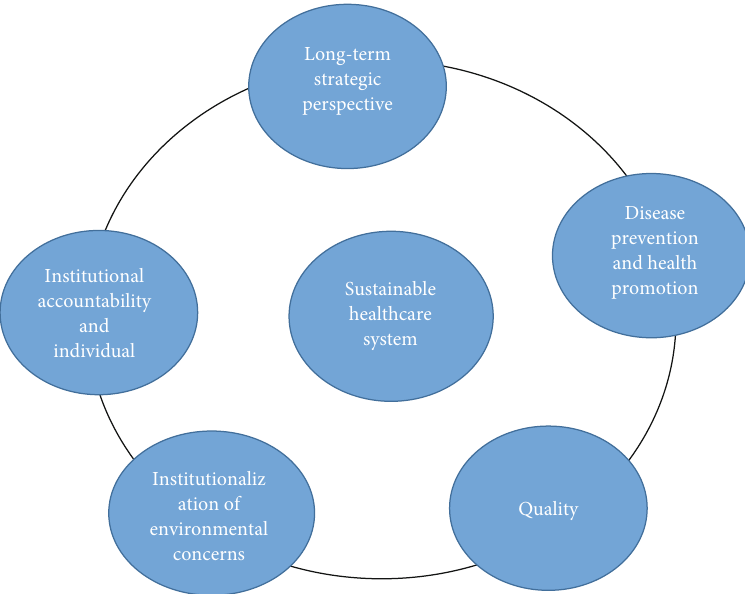
Figure 1: Dimensions of healthcare system